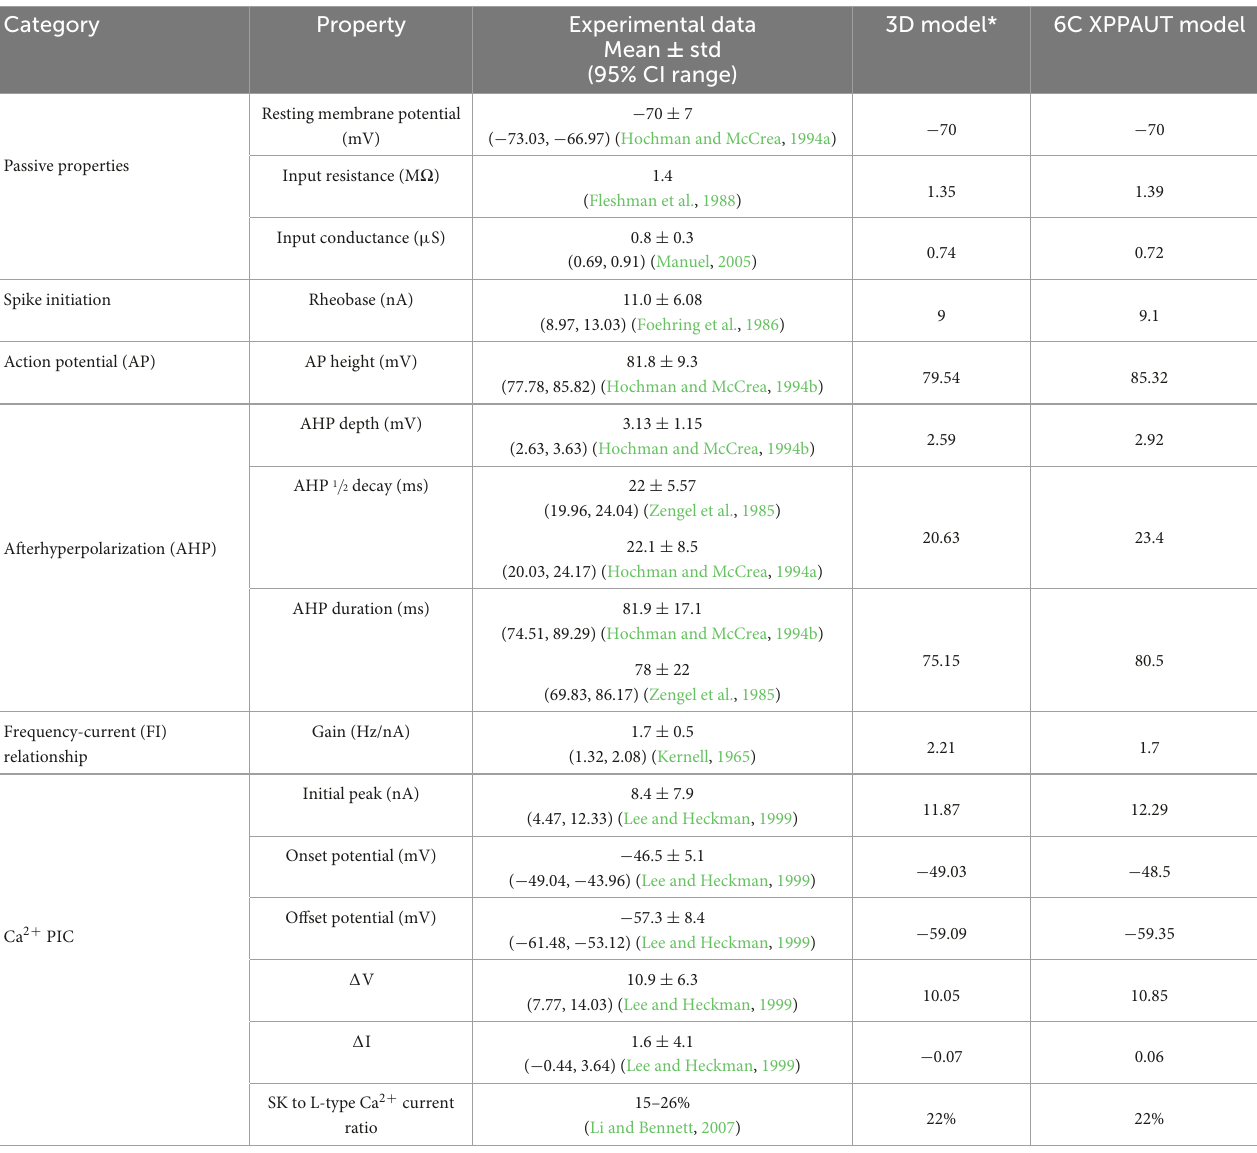
TABLE 3 Comparison between the 3D and XPPAUT models’ electrical properties vs. experimental data.